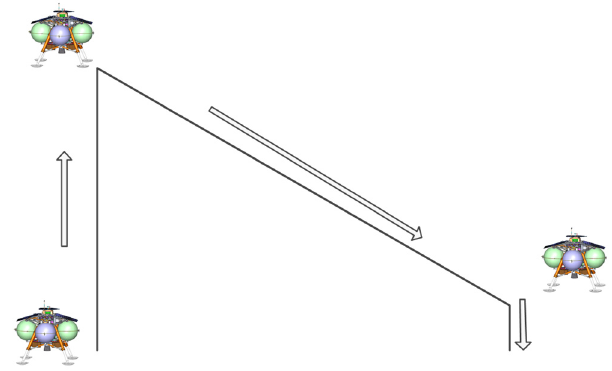
Figure 2. Second flight scenario sketch.